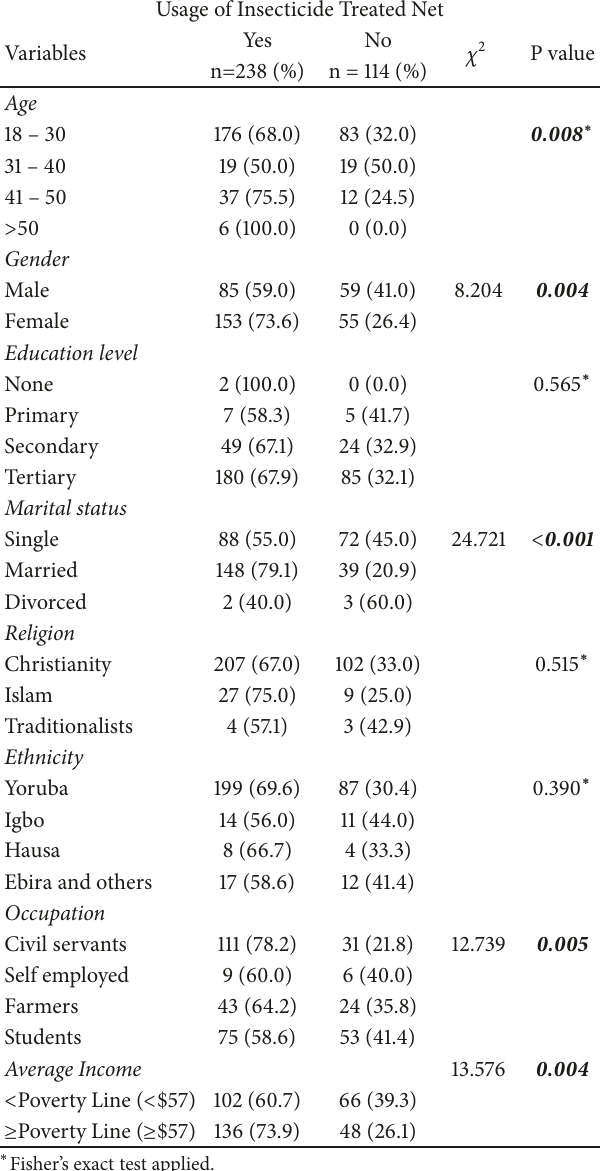
Table 3: Assessment of knowledge of malaria transmission, sleep pattern, and frequency of malaria attacks among respondents.